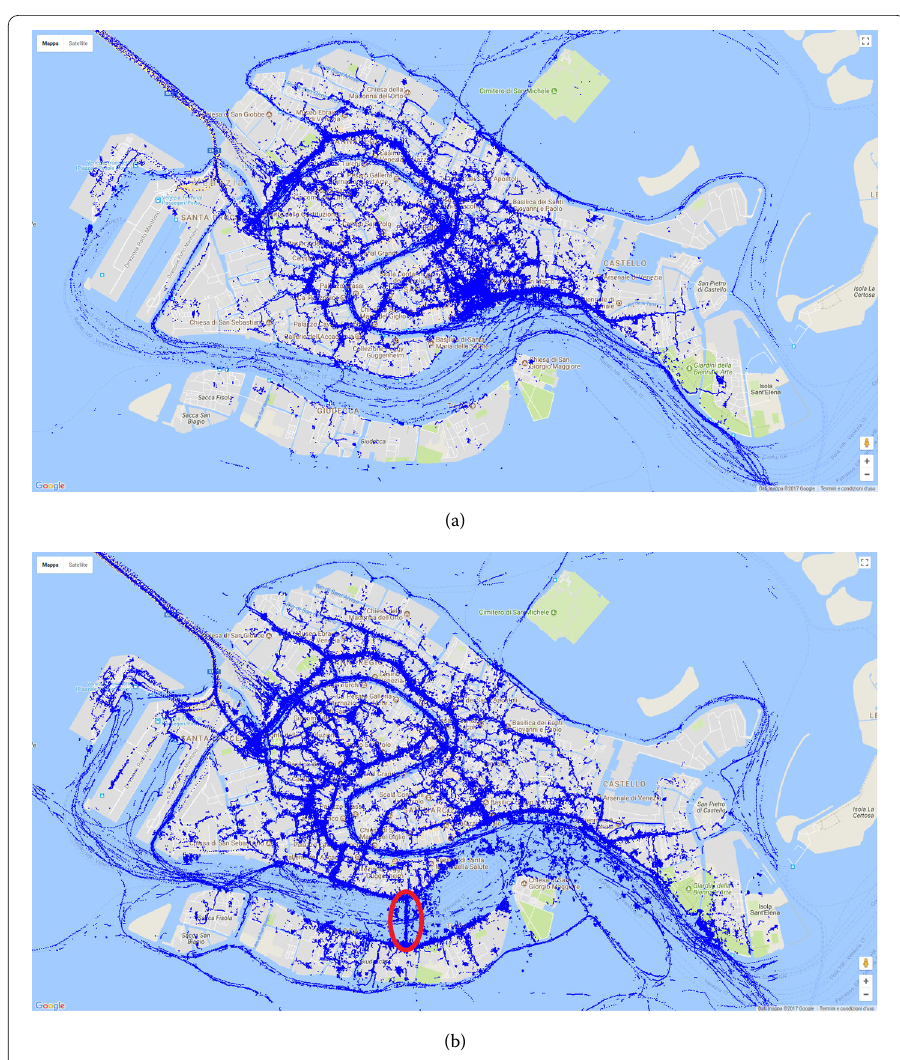
Figure 1 Examples of the spatial distribution of the GPS data recorded in the Venice historical centre: the top picture refers to the Carnival dataset (26/02/2017 from 12:00 p.m. to 02:00 p.m.). The bottom picture to the FestadelRedentore dataset (15/07/2017 from 19:00 p.m. to 21:00 p.m.). The red circle points out the Redentore bridge location, which is a floating bridge installed during the